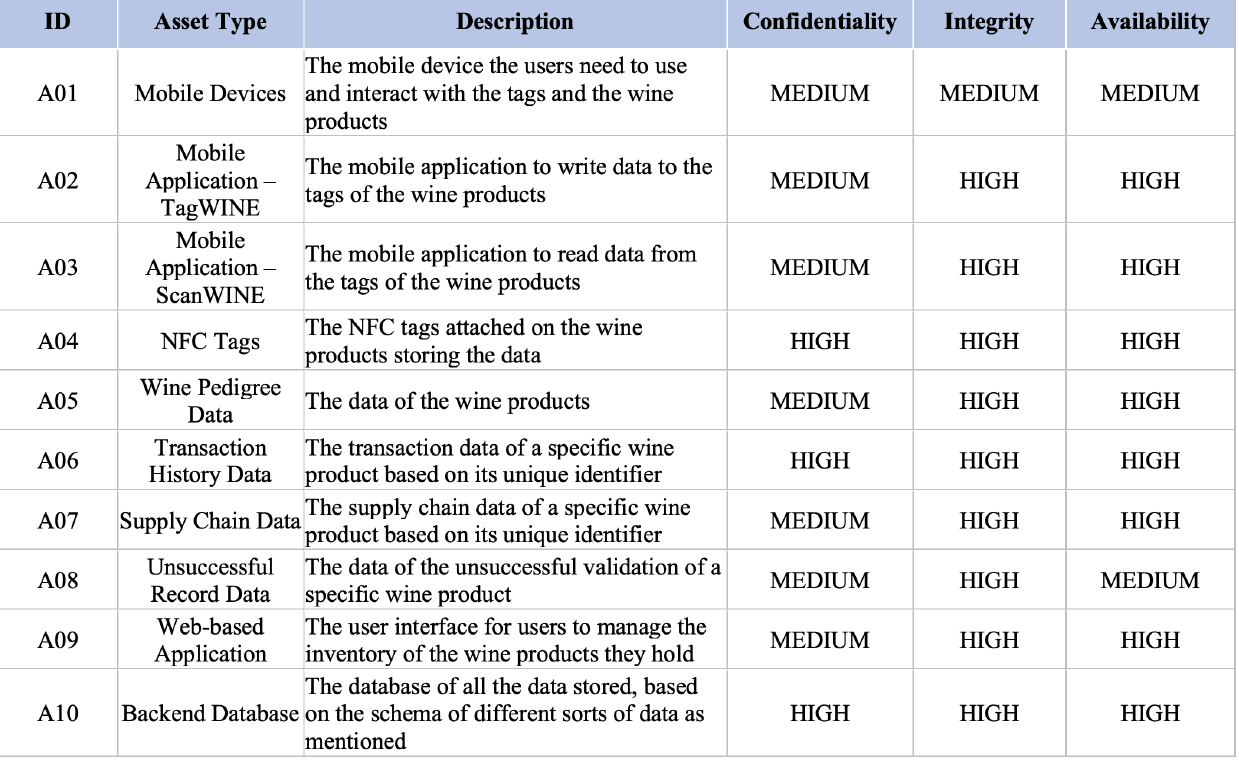
Figure A3. Asset analysis of